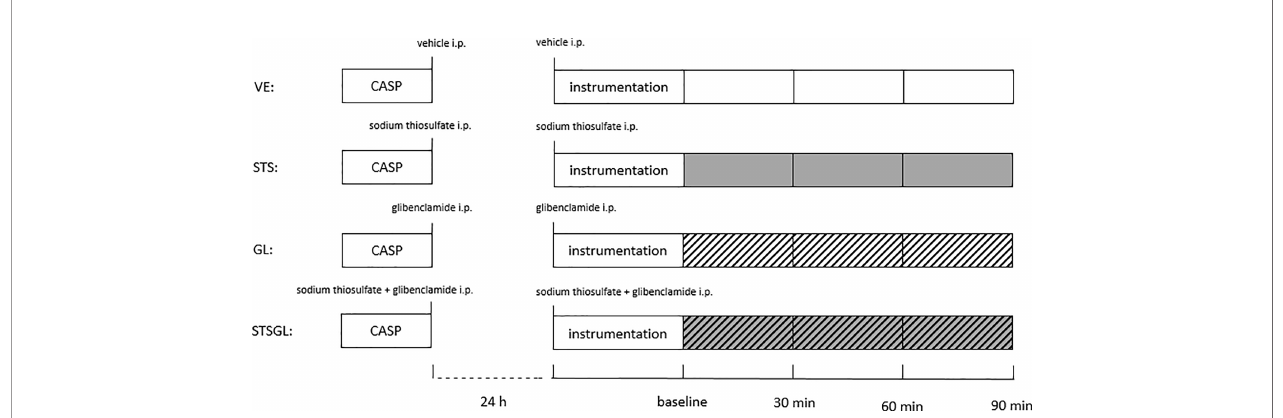
FIGURE 1 | Experimental protocol. Colon ascendens stent peritonitis (CASP)-surgery was carried out 24 h before the experiment. Intraperitoneally treatment with vehicle (VE), sodium thiosulfate (STS), glibenclamide (GL) or sodium thiosulfate + glibenclamide (STSGL) was carried out after CASP surgery and directly before the